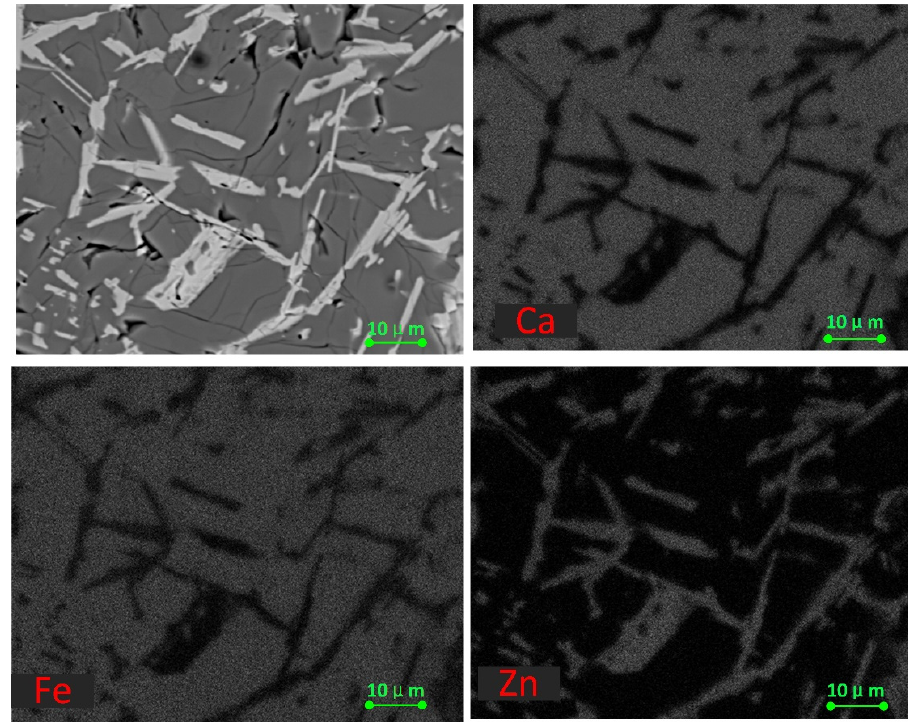
Figure 7. Main element distribution of the roasted product with the roasting time of 0.5 h.